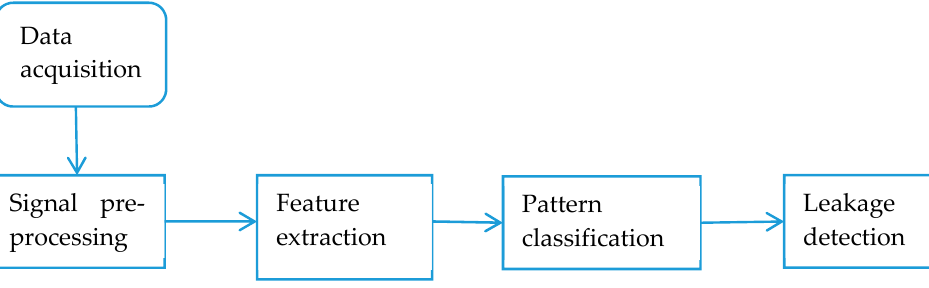
Figure 9. The architecture of pipeline leaks detection based on digital signal processing .